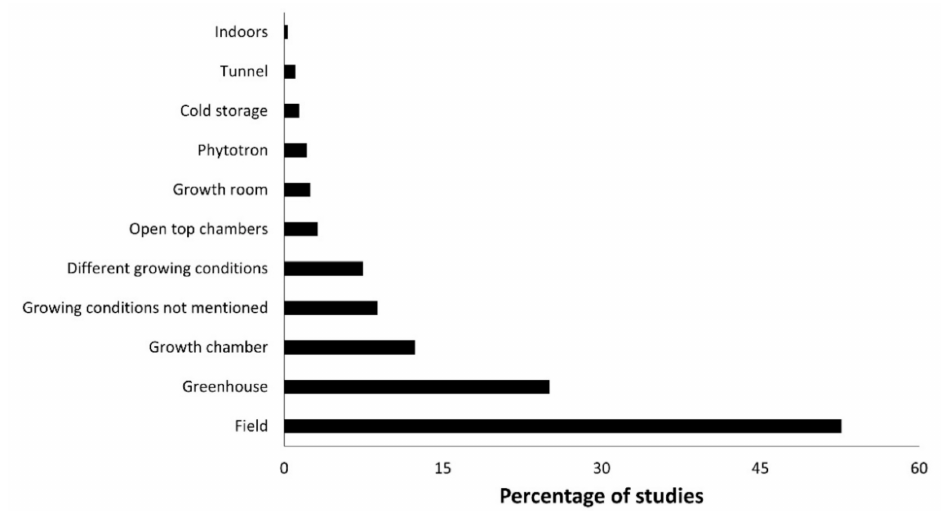
Figure 4. The conditions in which the experimental material was grown, ordered by percentage of